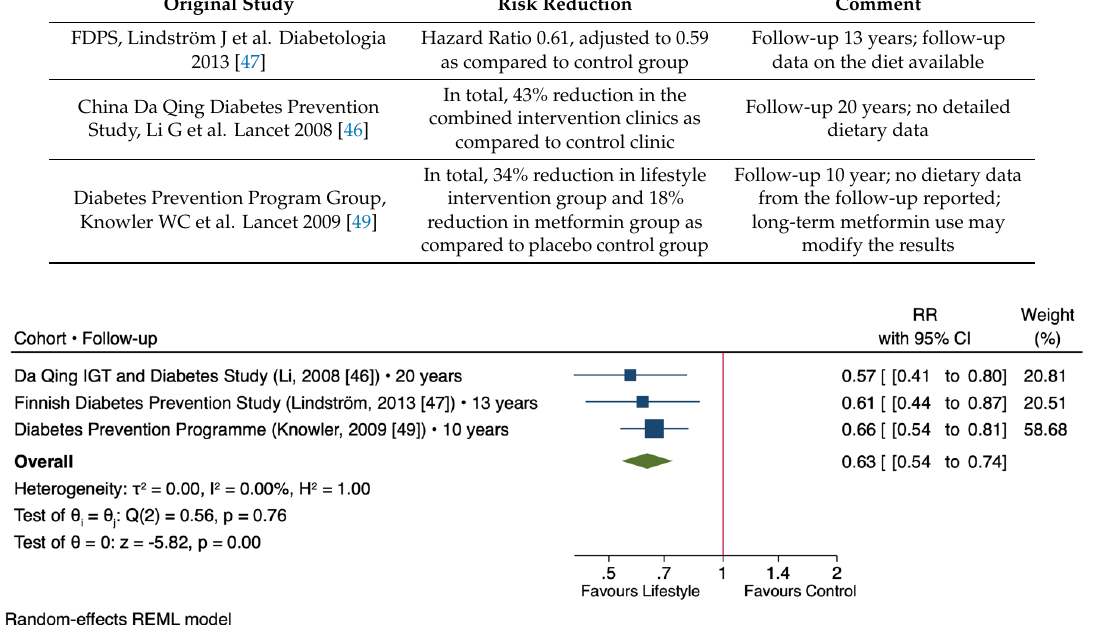
Figure 4. Forest plot of randomized controlled trials investigating the long-term post-intervention effect of lifestyle changes on type 2 diabetes risk. The pooled effect estimate for the overall effect is represented by the green diamond. Data are expressed as weighted risk ratios with 95% confidence intervals (CIs) using the REML random-effects model. Inter-study heterogeneity was tested by the Cochrane Q-statistic at a significance level of p < 0.10 and quantified by I 2 , where a level of ≥50% represented substantial heterogeneity. Table 4. Long-term post-intervention preventative effect on the incidence of type 2 diabetes in the former intervention groups compared to control groups in three randomized controlled lifestyle intervention studies.